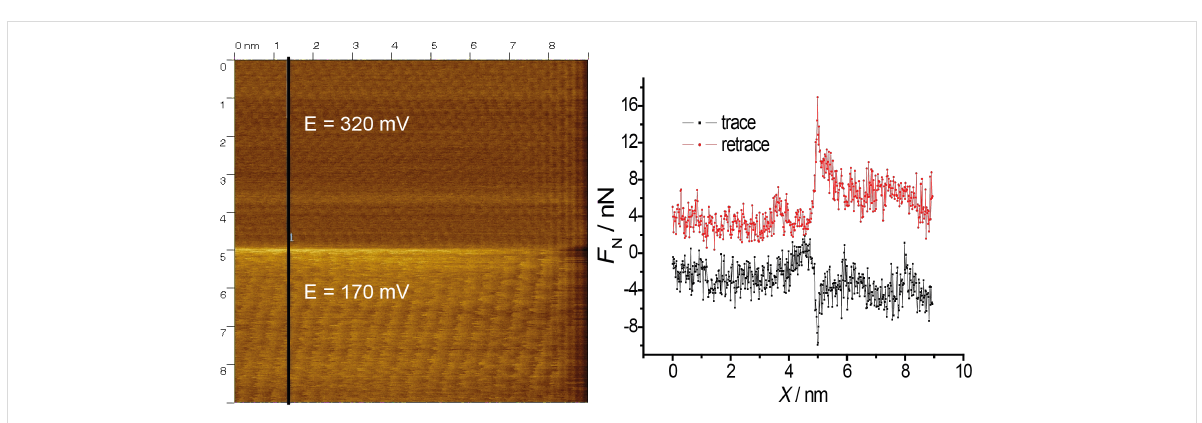
Figure 5: Stick–slip atomic resolution and cross section analysis for a potential jump from 320 mV (Au(111)/sulfate) to 170 mV (2/3 Cu adlayer), cross section along the vertical line as indicated; F N = 45 nN; scan rate 275 nm/s.